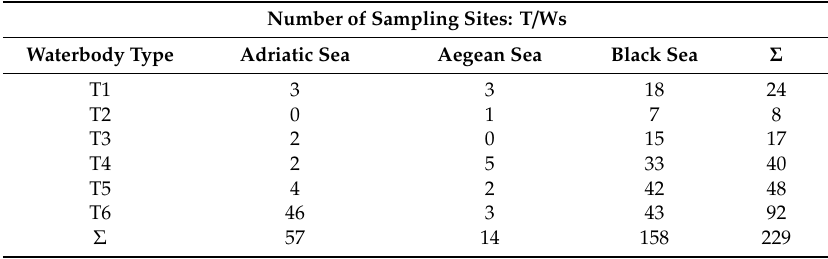
Table 2. The number of sites per watershed and per waterbody type.